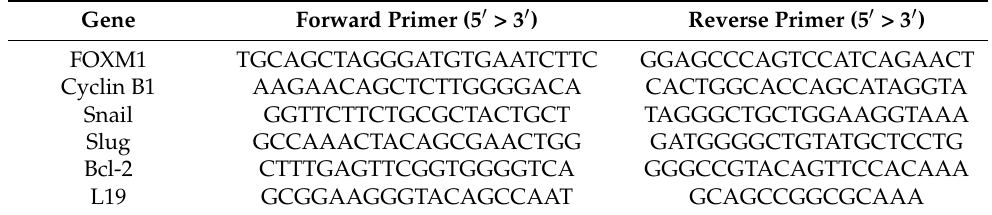
Table 2. List of primer sequences used in this